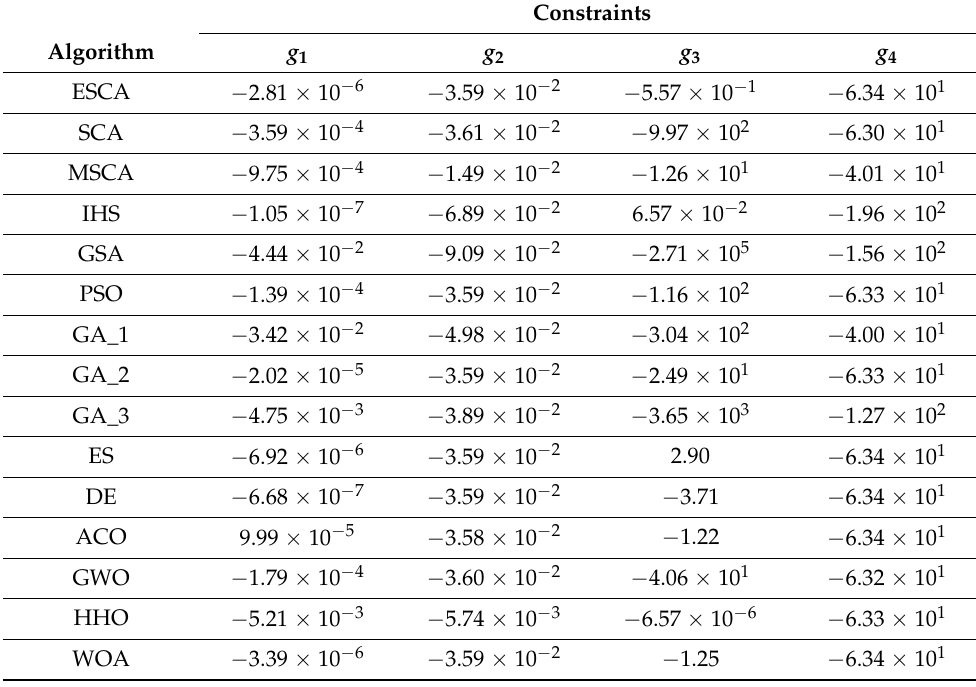
Table 25. Constraints of the best solutions obtained for the pressure vessel problem.